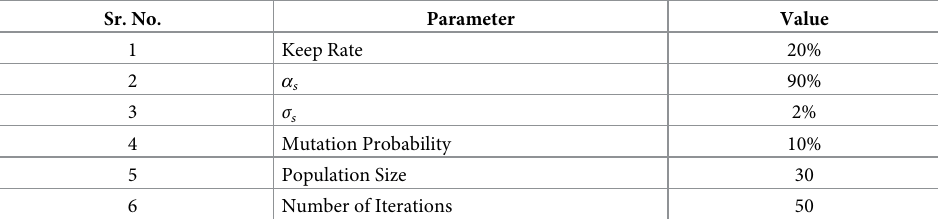
Table 1. Simulation parameters of BBO. Sr.